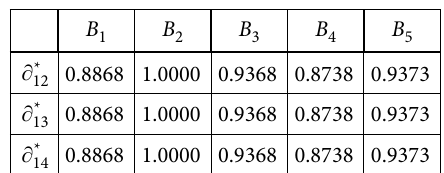
Table 9. The modified weights